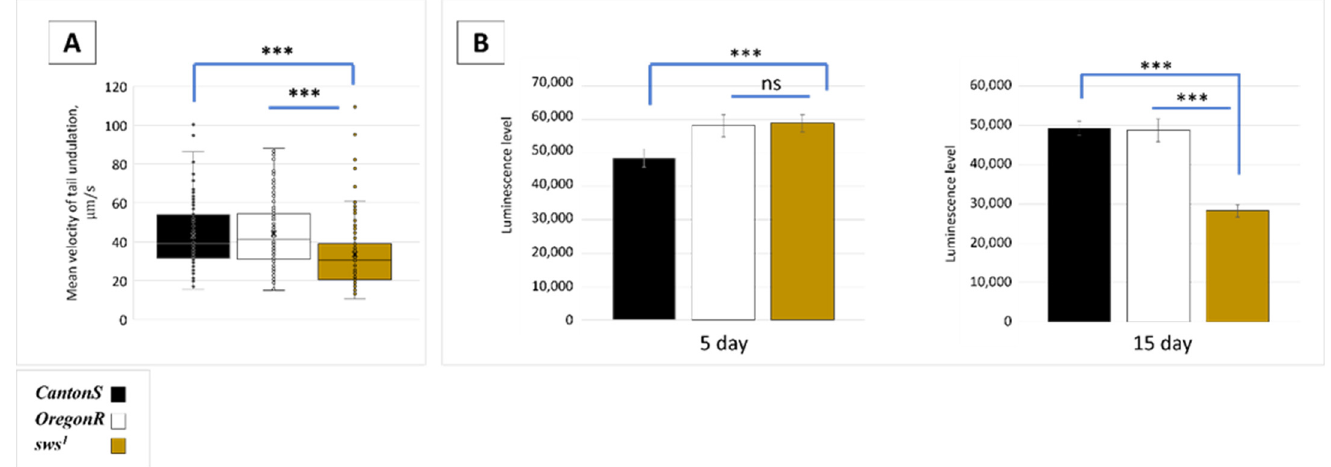
Figure 7. Spermatozoa analysis. ( A ) Mean velocity of a tail end undulation of a spermatozoid, extracted from a seminal vesicle, n = 111. Steel test, *** p < 0.001. Note that the performance of the sws 1 mutants is weaker than that of the controls. ( B ) The level of luminescence corresponding to the level of ATP extracted from testes and seminal vesicles of 5 and 15- day-old males. Dunnett’s test, *** p < 0.001, ns—no significant difference ( p > 0.05), n = 100.